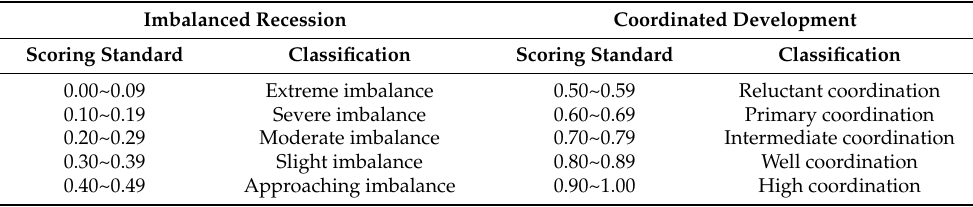
Table 3. The division standard for coupling coordination